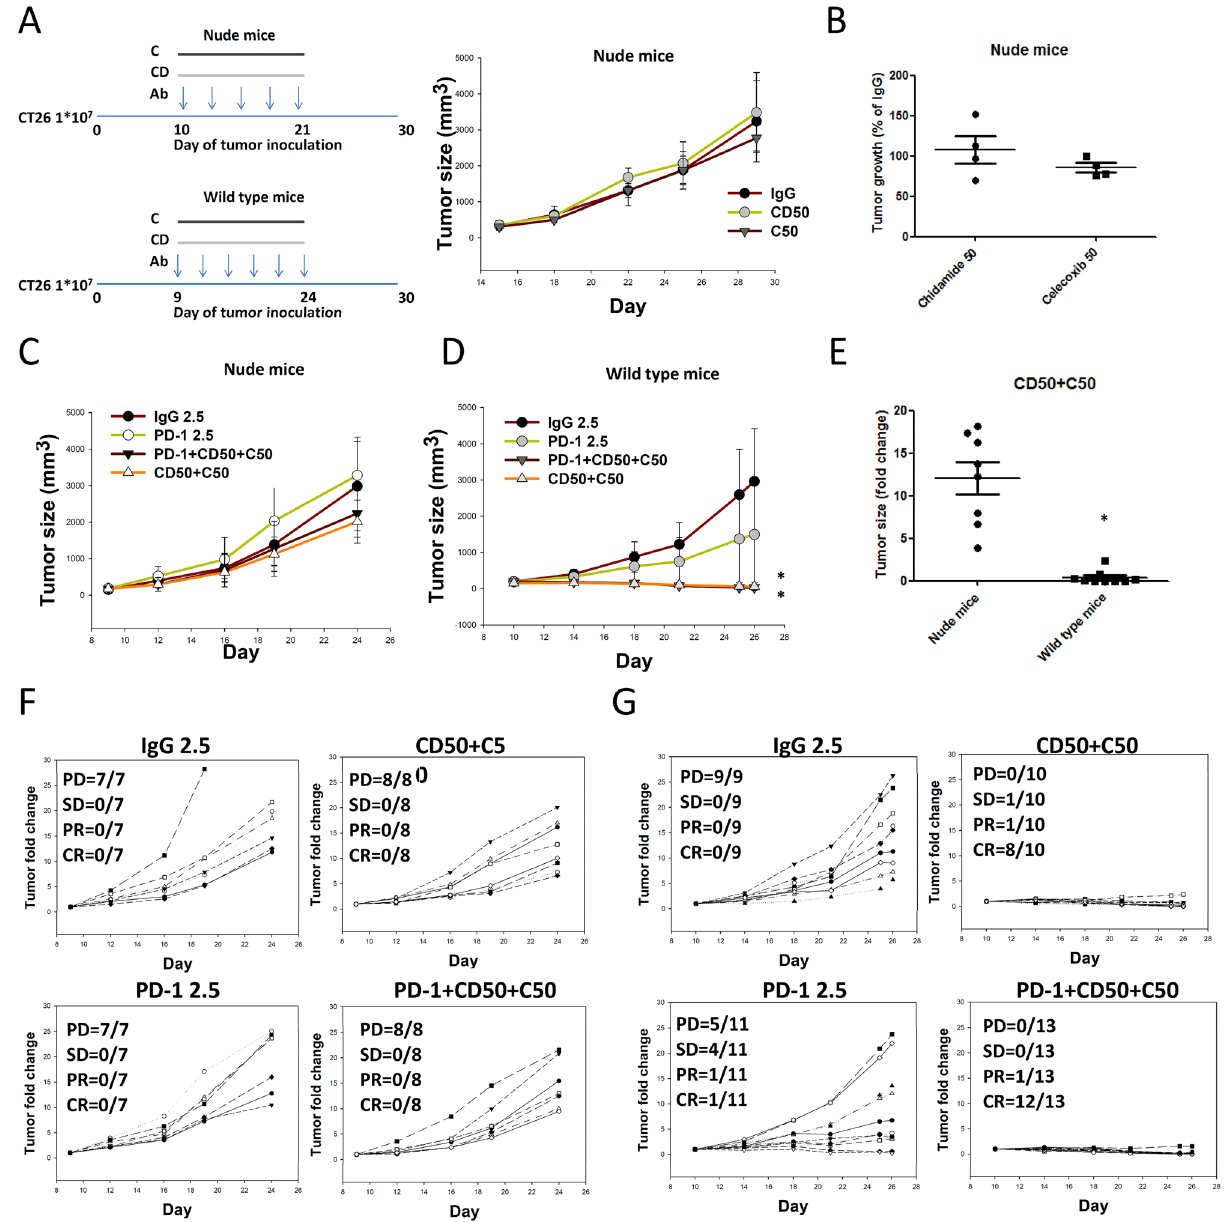
Figure 3. Chidamide + celecoxib demonstrate anticancer activity by immune activation and enhance anti-PD-1- induced immunotherapy in a wild type and immunodeficient nude mice allograft CT26 mouse model. ( A ) CT26 tumor-bearing nude mice were orally administered a chidamide-k30 solution (CD, 50 mg/kg) once daily from days 10 to 21 (Day 15 mean TV, 174 ± 39 mm 3 ), and celecoxib (C, 50 mg/kg) once daily from days 15 to 29. Endpoint tumor size is presented as tumor volume (TV; mm 3 ). Results are shown as mean ± standard deviation (SD). *p < 0.05 vs. anti-IgG; (n = 4). ( B ) Tumor growth suppression % graphs for CT26 tumor-bearing nude mice. ( C ) CT26 tumor- bearing nude mice were orally administered a chidamide-k30 solution (CD, 50 mg/kg) once daily from days 9 to 21 (Day 9 mean TV, 191 ± 10 mm 3 ), and celecoxib (C, 50 mg/kg) once daily from days 9 to 24. The mice were treated with anti-PD-1 antibody (2.5 mg/kg, i.p.) once every 3 days on days 9, 12, 15, 18, 21, and 24. Endpoint tumor size is presented as tumor volume (TV; mm 3 ). Results are shown as mean ± standard error of the mean (SEM). *p < 0.05 vs. anti-IgG; (n = 7–8). ( D ) CT26 tumor-bearing wild type mice were orally administered a chidamide-k30 solution (CD, 50 mg/kg) once daily from days 8 to 23 (Day 10 mean tumor volume (TV), 150–190 mm 3 ), and celecoxib (C, 50 mg/kg) once daily from days 8 to 23. The mice were treated with anti-PD-1 antibody (2.5 mg/kg, i.p.) once every 3 days on days 8, 11, 14, 17, 20, and 23. Endpoint tumor size is presented as TV (mm 3 ). Results are shown as mean ± standard error of the mean (SEM). *p < 0.05 vs. anti-IgG; (wild type mice n = 8). ( E ) Tumor growth suppression % graphs for CT26 tumor-bearing nude vs. wild type mice (n = 8 and 20). ( F ) Individual tumor growth graphs for CT26 tumor-bearing nude mice (n = 7–8). Number of tumor-free mice per total number of mice is shown at the top left corner of each panel. ( G ) Individual tumor growth graphs for CT26 tumor-bearing wild type mice (n = 9–13). Number of tumor-free mice per total number of mice is shown at the top left corner of each